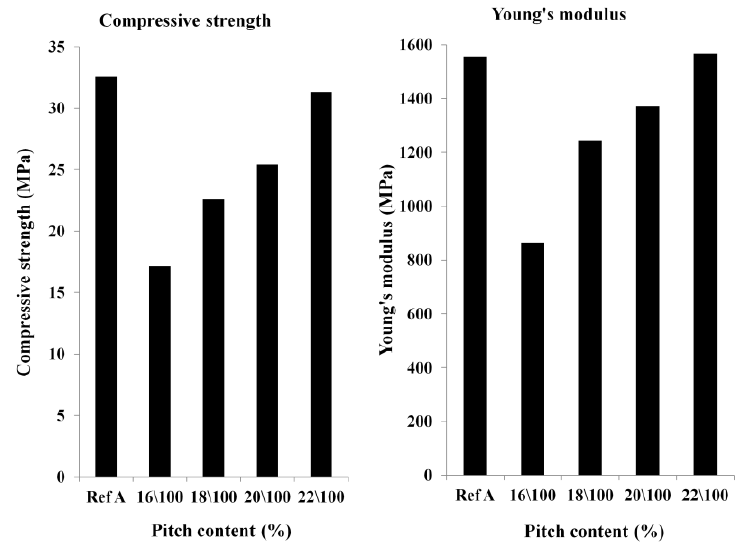
Figure 5. The effect of pitch content on the compressive strength and Young’s modulus of anodes containing 10% charcoal compared to the reference anode (Ref A).